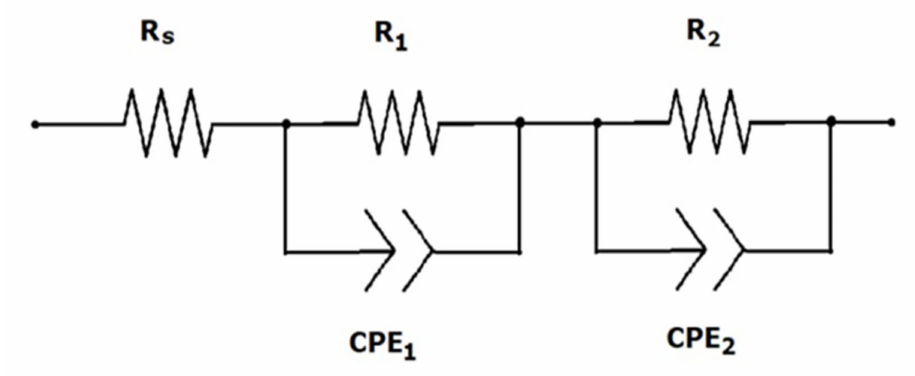
Figure 9. Equivalent circuit of the DSSC.